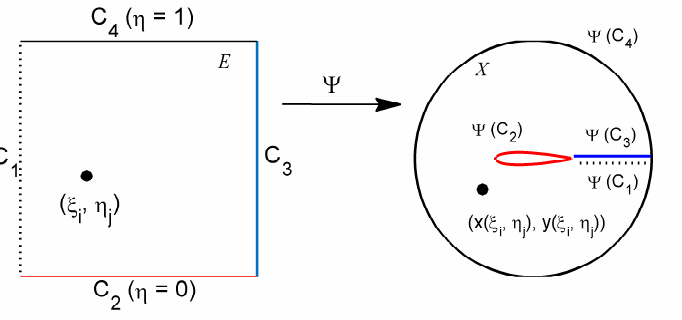
Figure 2. Mapping between parametric region E and physical region X